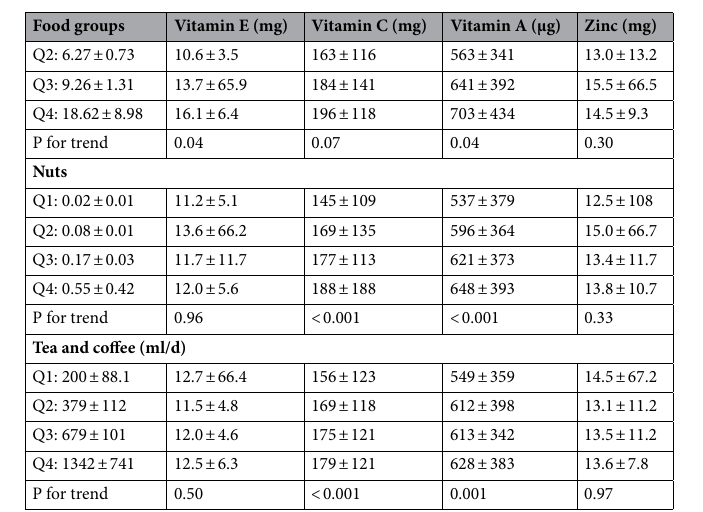
Table 2. Antioxidant intakes with respect to quartiles of food group consumption. a Values are serving/day, with the exception of sugar-sweetened soft drinks, Tea and coffee. b Data are mean ± SD using ANOVA test. c P for trend were obtained by the linear regression analysis using the median of each quartile as a continuous variable for each food group.